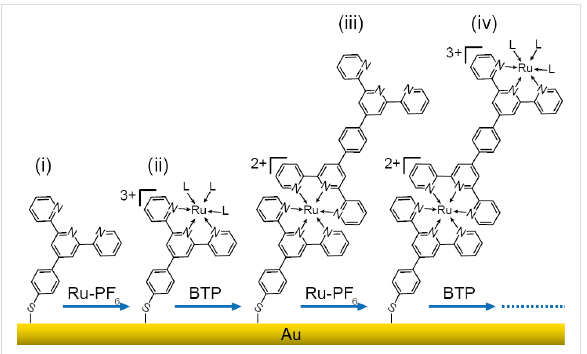
Figure 1: Stepwise Ru(TP) 2 -complex wire growth by alternate addi- tion of the Ru-PF 6 precursor in ethanol and BTP solution, (i)–(iv) see text above; L = ligand (acetone or ethoxide